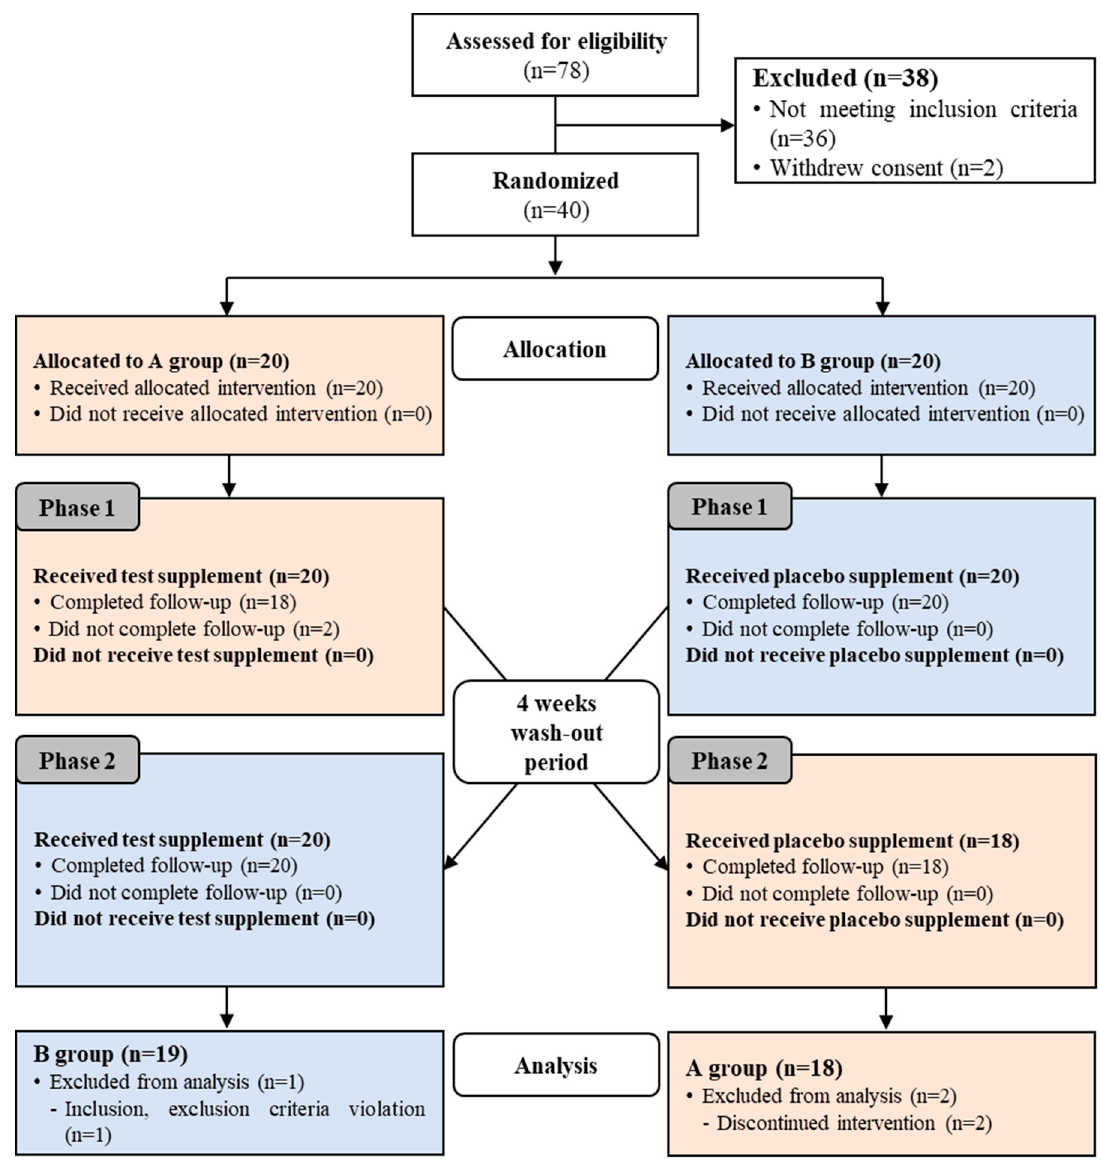
Figure A1. CONSORT 2010 flow